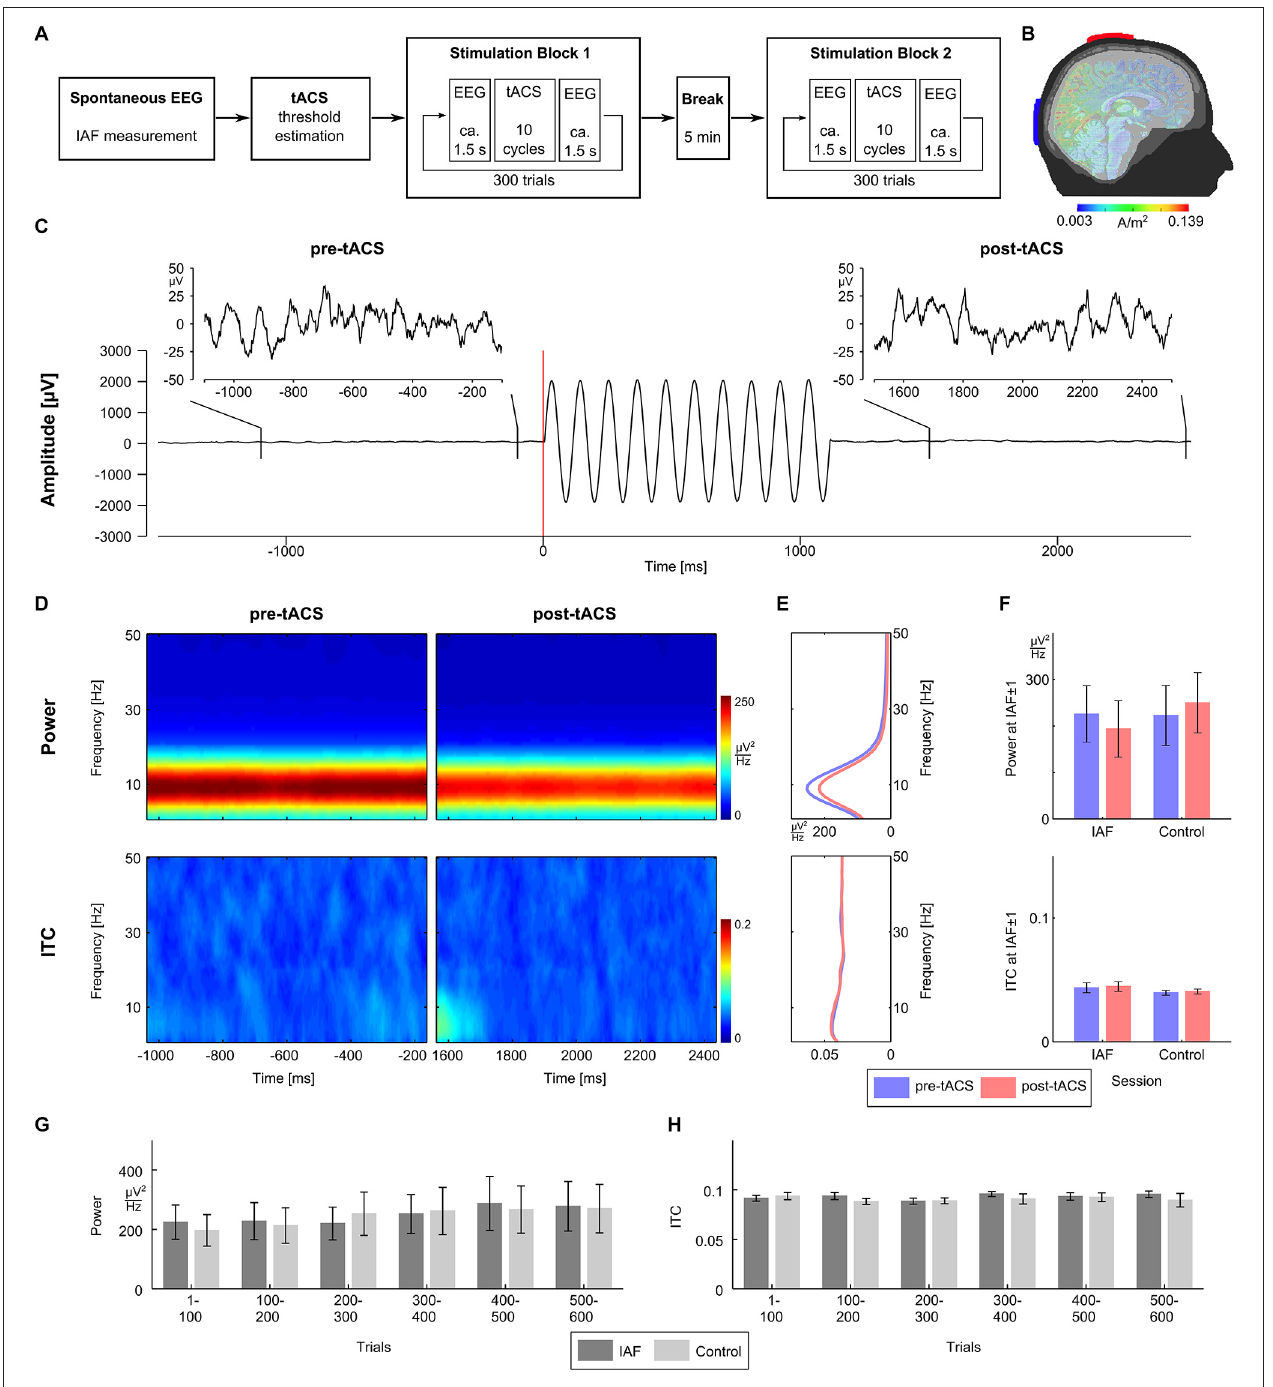
data (electrode P3) from a typical trial. The participant was stimulated with ten cycles of tACS at 9 Hz starting at 0 ms. For each trial, the pre-tACS epoch from − 1100 to − 100 ms relative to tACS onset and post-tACS epoch from 1500 to 2500 ms relative to tACS onset were chosen for analysis. (D) Time-frequency plots of power (upper row) and intertrial coherence (ITC, bottom row) for the pre-tACS (left column) and the post-tACS epoch (right column) in the IAF session. (E) Power (upper panel) and ITC (lower panel) averaged across the pre-tACS (blue) and the post-tACS epoch (red) in the IAF session. (F)